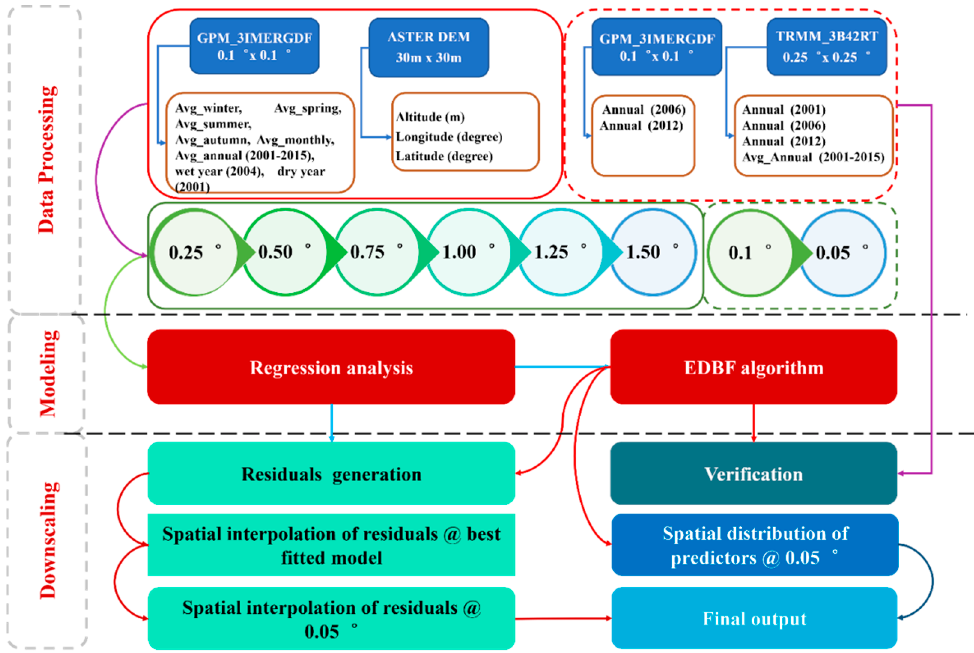
Figure 1. Proposed methodology to predict the high-resolution downscaled weighted precipitation.